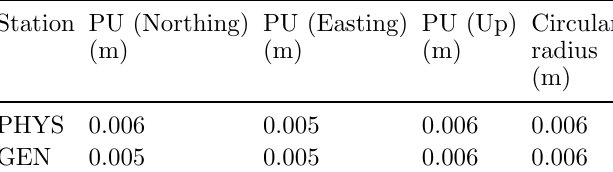
Table 11. 95% PU and circular radius values (fully constrained